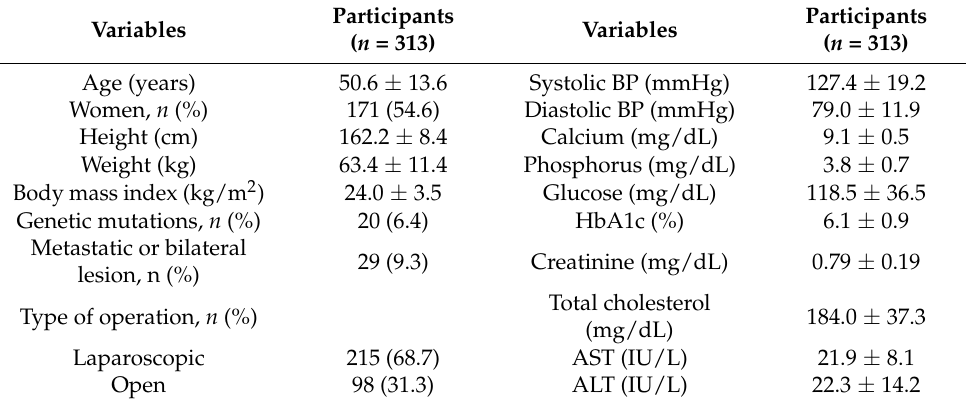
Table 1. Baseline characteristics of study participants.